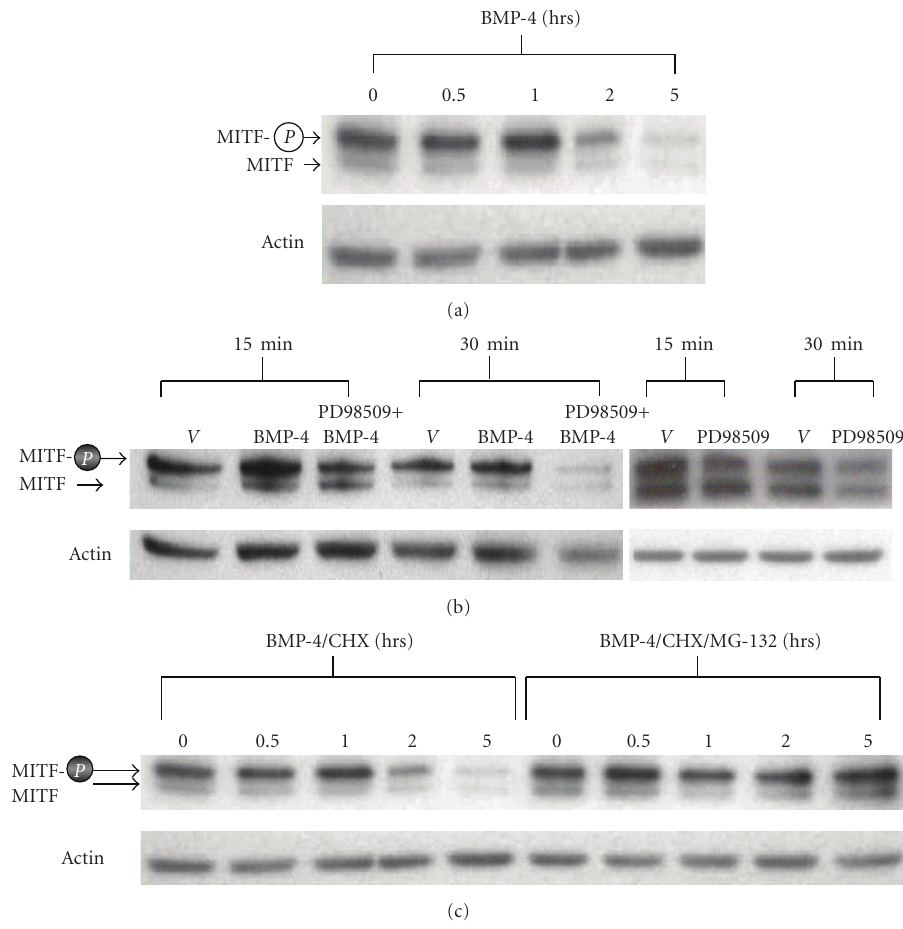
Figure 3: E ff ects of BMP-4 on the level of phosphorylated level of MITF . (a) Paired cultures of melanocytes were treated with BMP-4 (25ng/mL) for 0, 0.5, 1, 2, and 5 hours. At each time point, cells were harvested and immunoblot analysis using monoclonal antibody against MITF was performed (provided by Dr. David Fisher from the Dana Farber Cancer Institute). This antibody has been shown to recognize both phosphorylated and nonphosphorylated MITF. As the loading control, the membrane was immunoblotted for actin. One representative result from three separate experiments is shown. (b) Paired cultures of melanocytes were treated with BMP-4 (25ng/mL) for 15 and 30 minutes in presence or absence of MEK inhibitor PD98509 at 10 μ m. At each time point, cells were harvested and the level of MITF protein was determined. One representative result from three separate experiments is shown. (c) Paired cultures of melanocytes were treated with BMP-4 (25ng/mL) and cycloheximide (15ug/mL) for 0, 0.5, 1, 2, and 5 hours in presence or absence of proteosome inhibitor MG-132 at 10 μ m. At each time point, cells were harvested and the level of MITF protein was determined using immunoblot analysis. One representative result from three separate experiments is